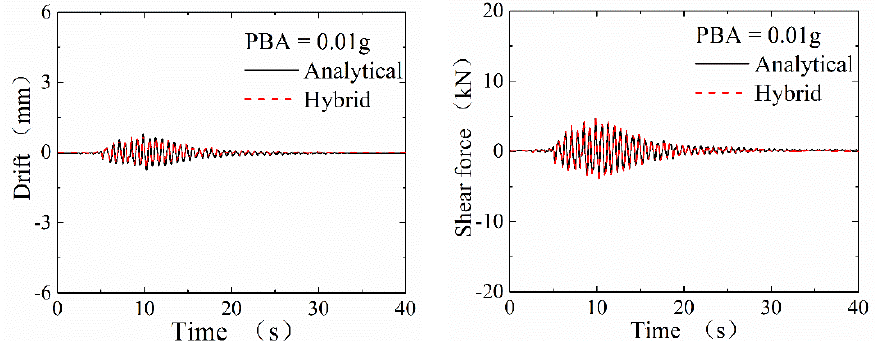
Figure 8. Test results of the 0.01 g case.